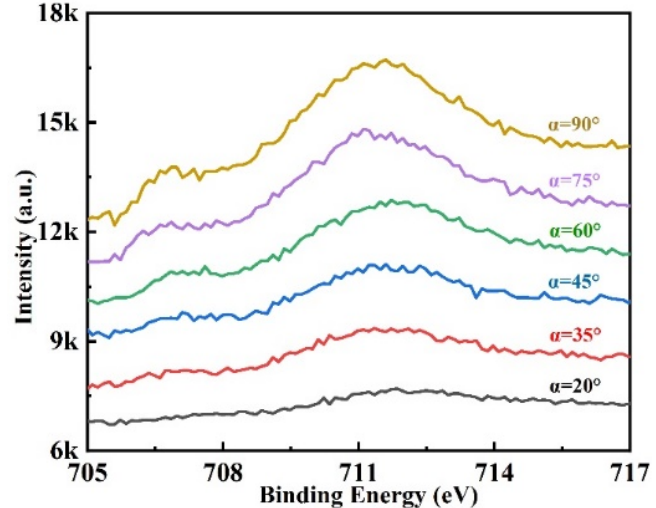
Figure 7. Spectra at different take-off angle of Fe 2p in NiFe(100 nm) thin film. Table 3. Relative peak intensities ( I s and I o ) and the I o / I s ratios for both iron oxides in the NiFe (100 nm) thin film. α (°)